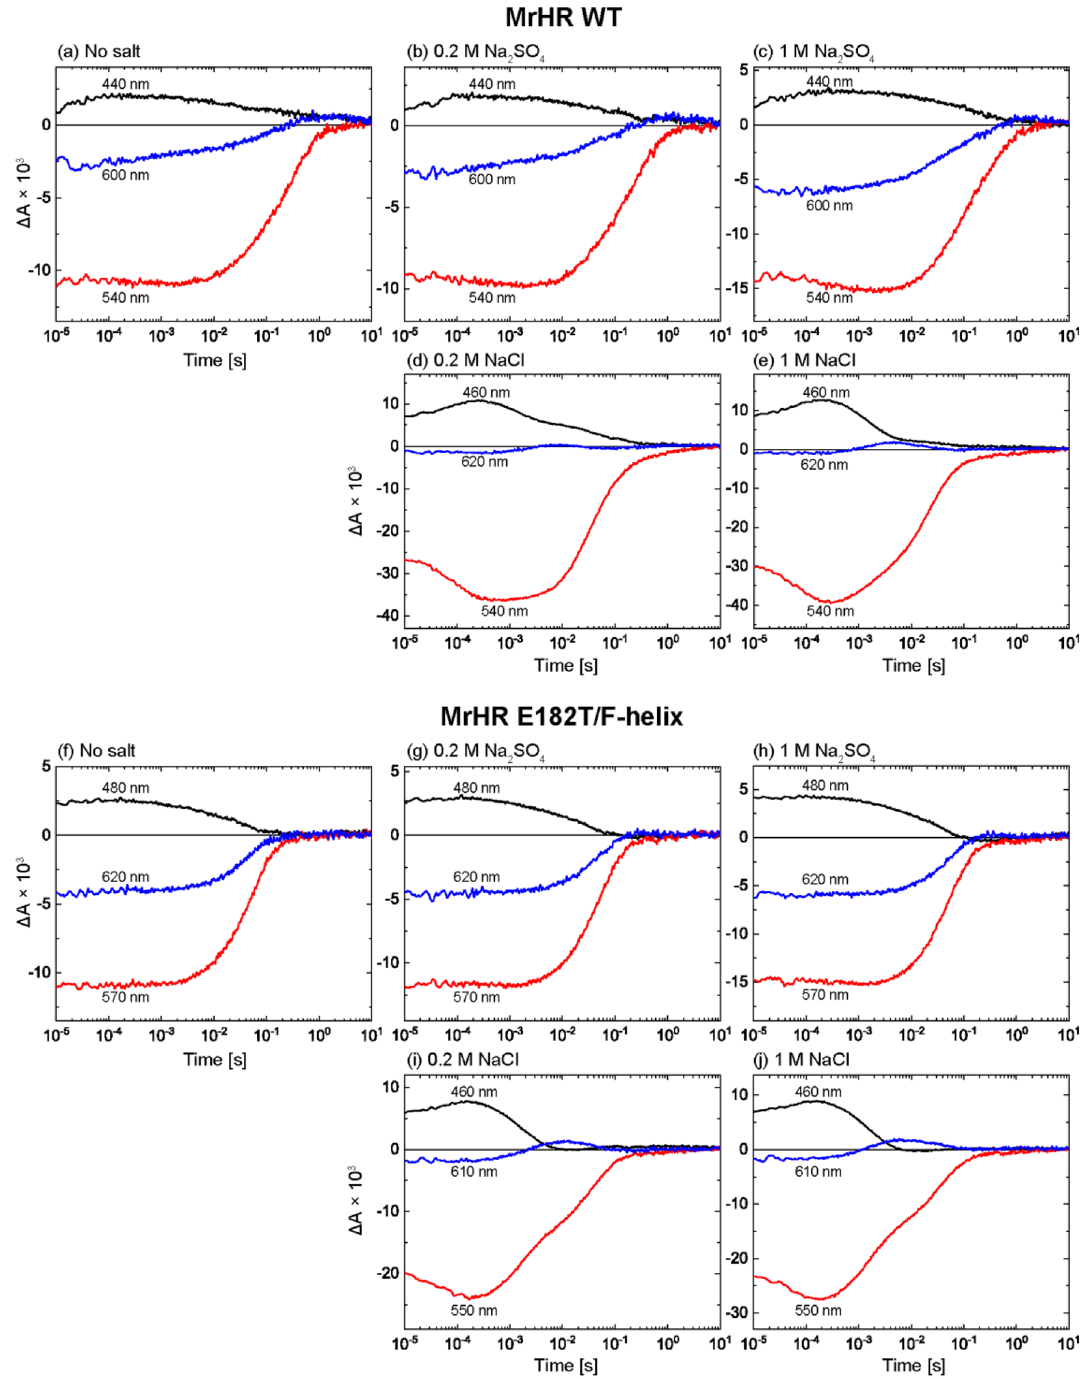
Figure 6. Flash-induced absorbance changes of wild-type MrHR ( a – e ) and the E182T/F-helix mutant ( f – j ). The E. coli membrane fragments were used for the samples after encapsulation into 15% acrylamide gels. The buffer solutions were 50 mM citric acid, pH 6.0, containing the salts indicated above the respective